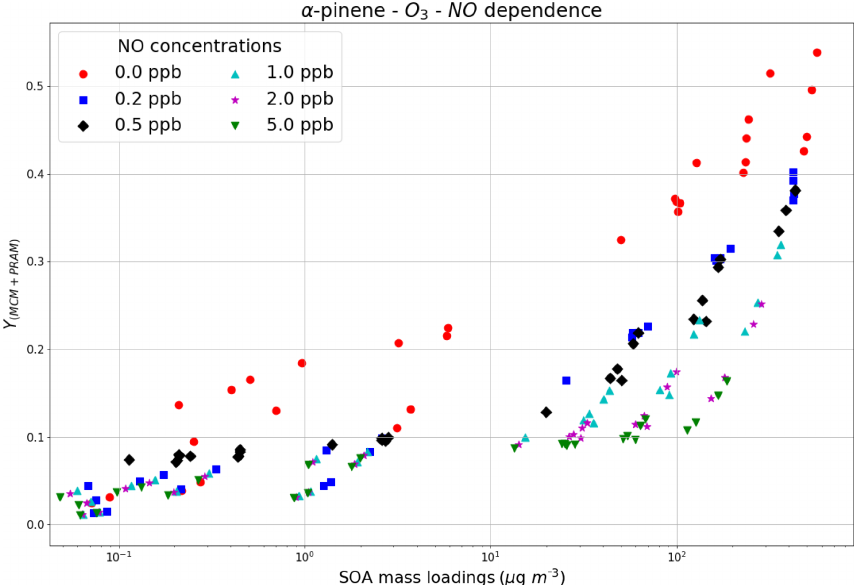
Figure 6. The SOA mass yields from O 3 oxidation of α -pinene modeled for different NO concentrations with the chamber setup. The model runs were performed using MCM +